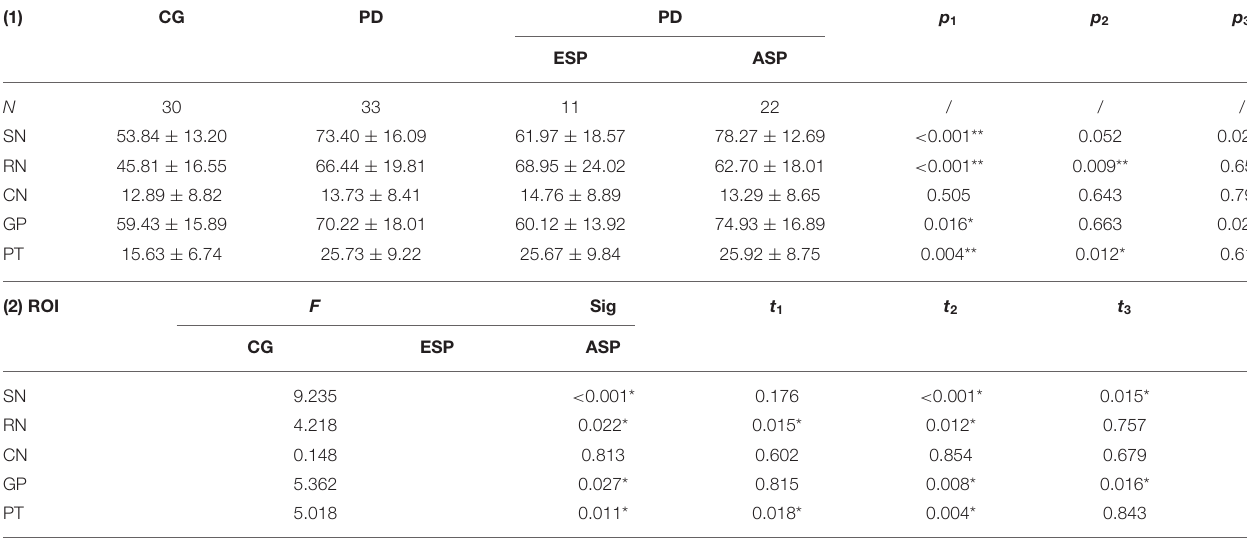
TABLE 2 | Comparisons of regional QSM values ( × 10 − 3 ) between CG and PD, CG and ESP, and ESP and ASP,